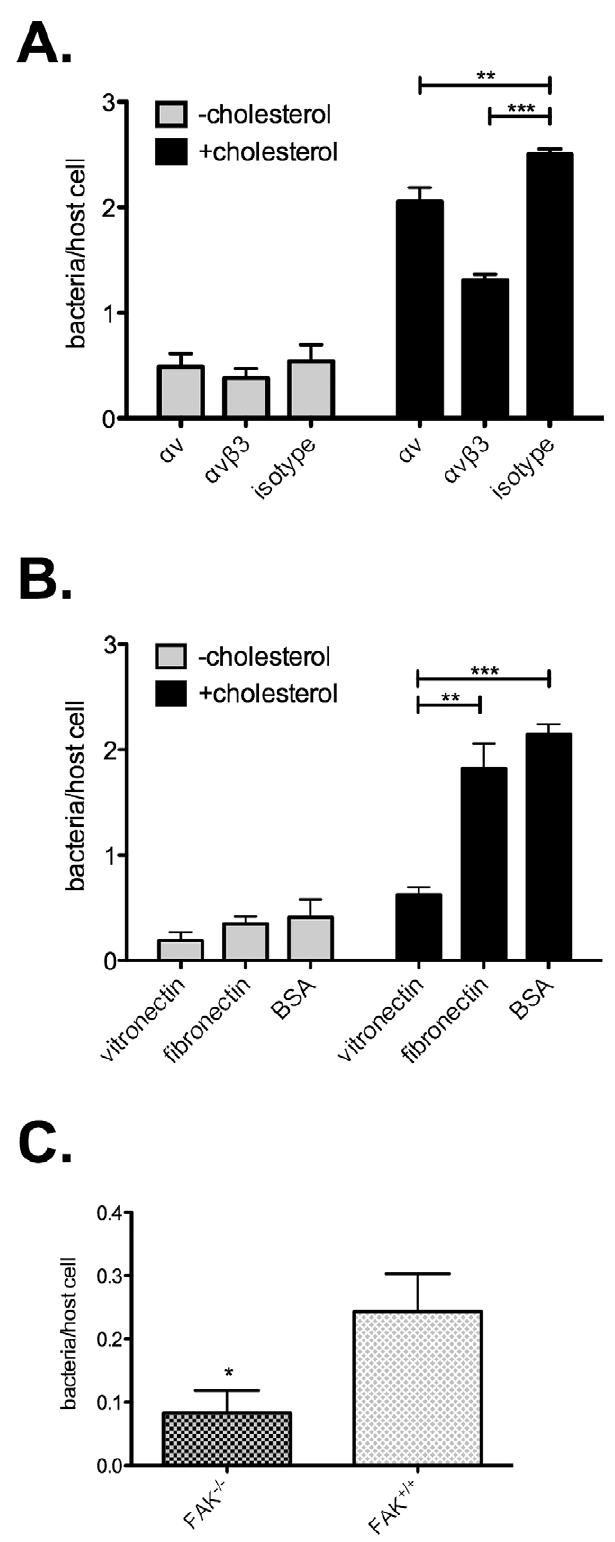
Figure 4. C. burnetii utilizes a V b 3 integrin for uptake in a cholesterol-dependent manner. (A). Entry assays in the presence of a V b 3 integrin blocking antibodies. C. burnetii internalization by 2 cholesterol MEFs was not significantly altered. In contrast, blocking either a V integrin or a V b 3 integrin in + cholesterol MEFs blocked